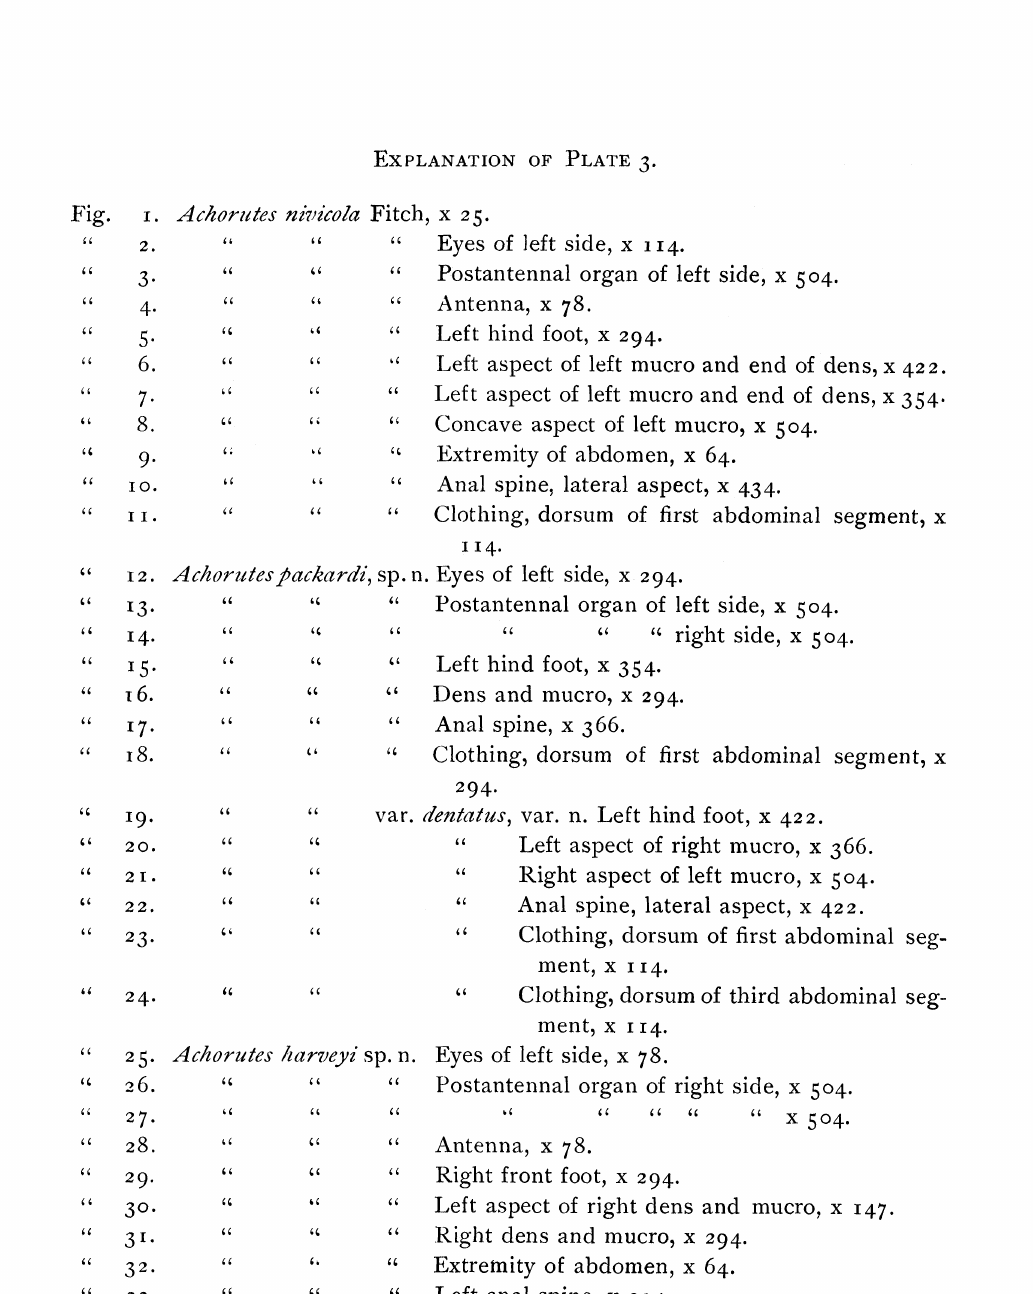
EXPLANATION OF PLATE